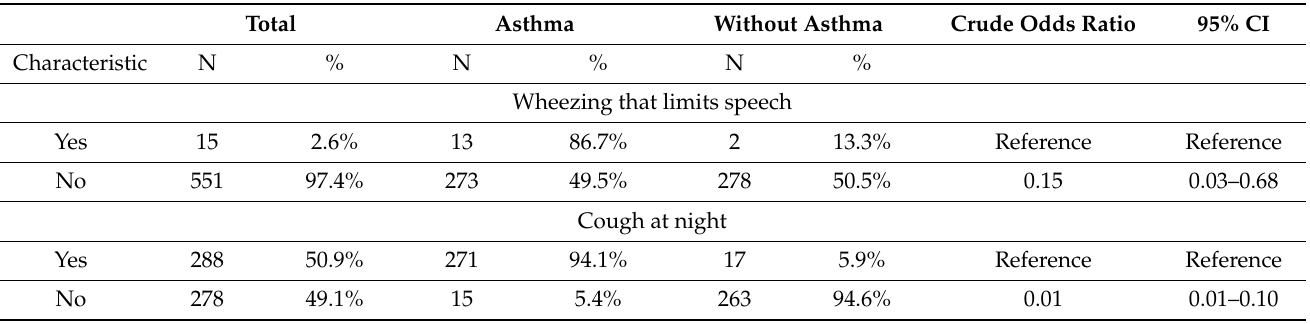
Table 3. Distribution and Crude Odds Ratios of Participant according to Asthma